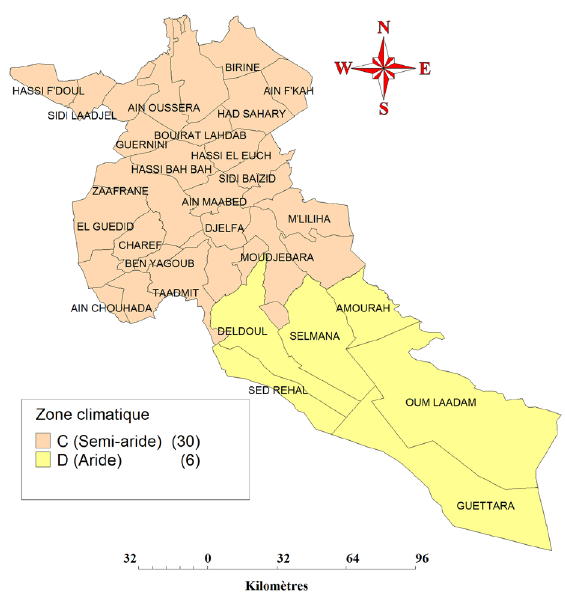
fig. 1. Climate zone in the department of Djelfa. Based on DTR 3.2: 2004.